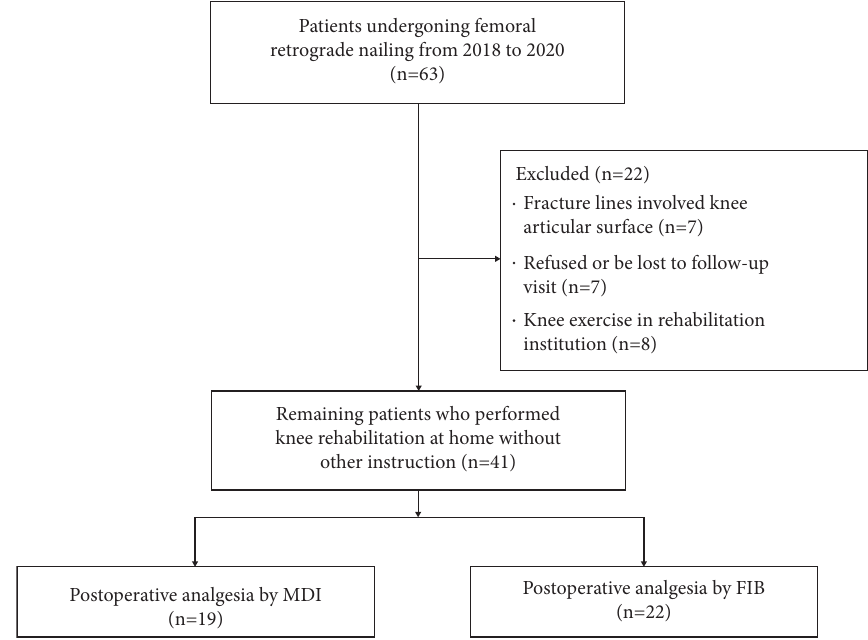
Figure 1: Enrollment flow